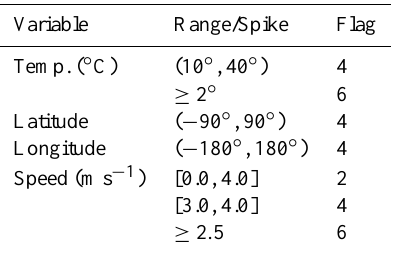
Table 2. Ranges, spike thresholds and flag categories used to char- acterize the quality of individual